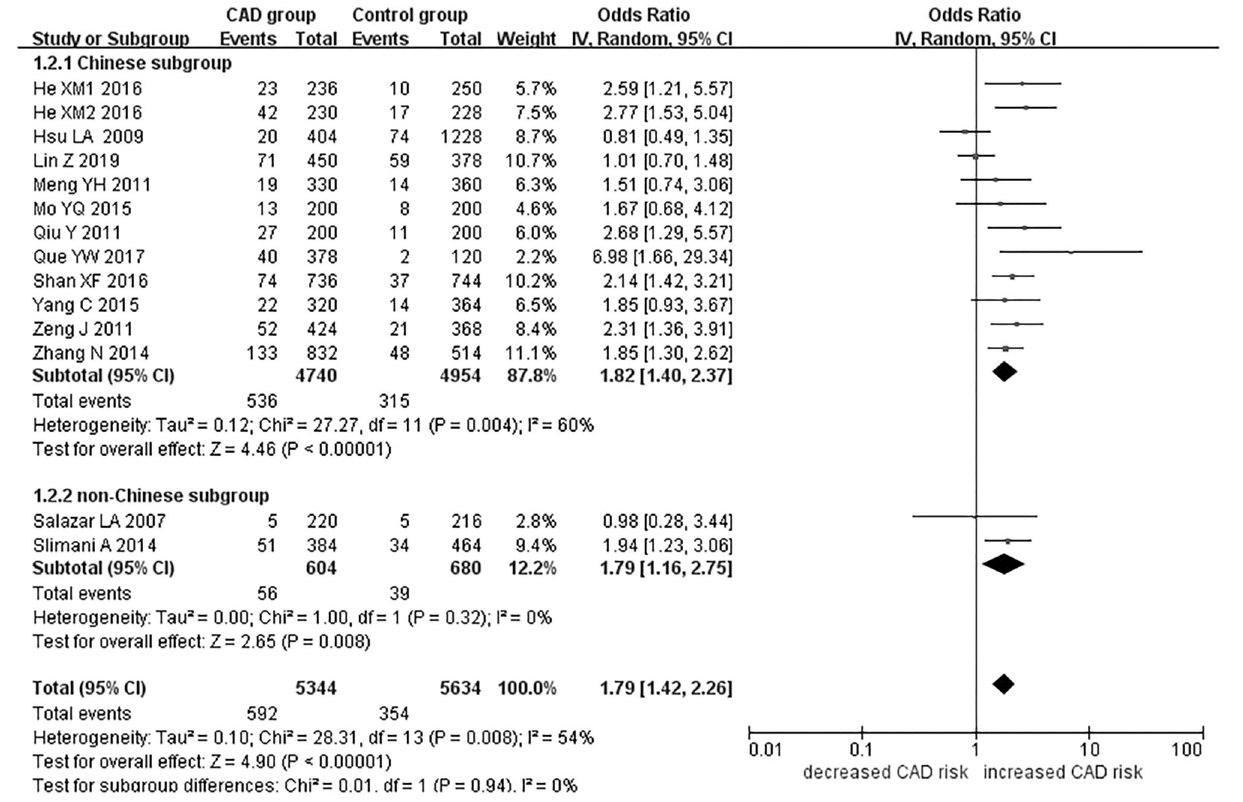
Frontiers in Cardiovascular Medicine |